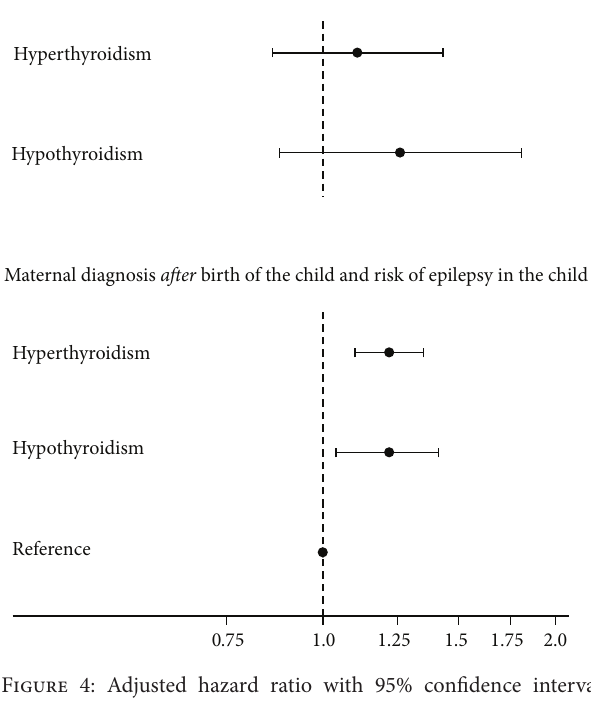
Figure 5: Adjusted hazard ratio with 95% confidence interval for risk of febrile seizure in singletons exposed to maternal hypothy- roidism first time diagnosed before or after birth of the child and registered in the Danish National Hospital Register (DNHR) before January 1, 2007. Reference is children born to mothers with no diagnosis of hyper- or hypothyroidism registered in DNHR before January 1, 2007. Model included gender of the child (boy/girl), following maternal variables obtained at the time of the child’s birth: age ( < 20, 20–24, 25–29, 30–34, 35–39, ≥ 40 years), parity including index pregnancy (1, 2, 3, ≥ 4), cohabitation (married/not married), income (1st, 2nd, 3rd, 4th quartile), origin (born in Denmark/not born in Denmark), residence (East/West Denmark), and maternal diagnosis of febrile seizure and/or epilepsy registered in the Danish National Hospital Register (DNHR) before January 1, 2007